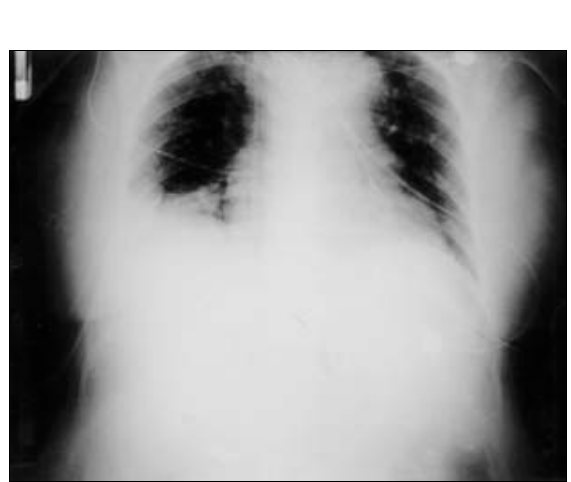
Fig. 2 - Radiografia de t(cid:243)rax obtida na Unidade de Terapia Intensiva, mostrando eleva(cid:231)ªo bilateral das cœpulas frŒnicas.